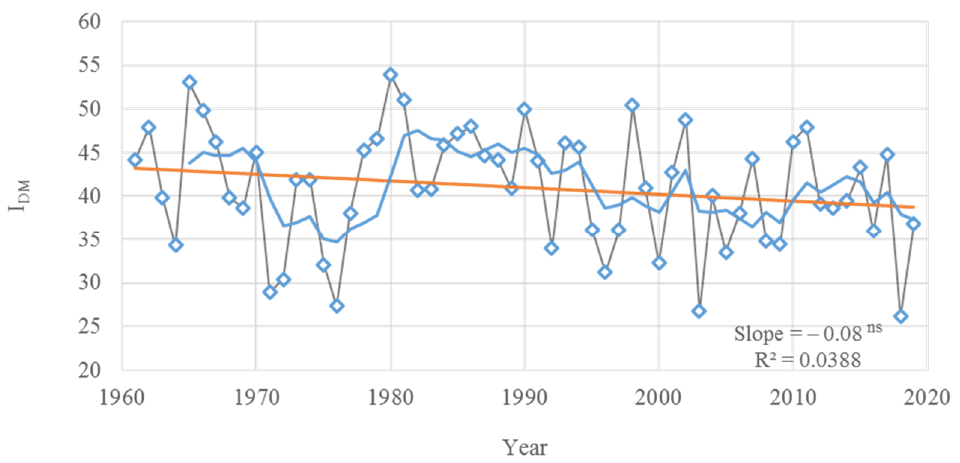
Figure 6. Time series of I DM for the selected synoptic station (Kiel-Holtenau). The blue line shows the 5 year moving average. The red line denotes a regression analysis. ns—not significant.